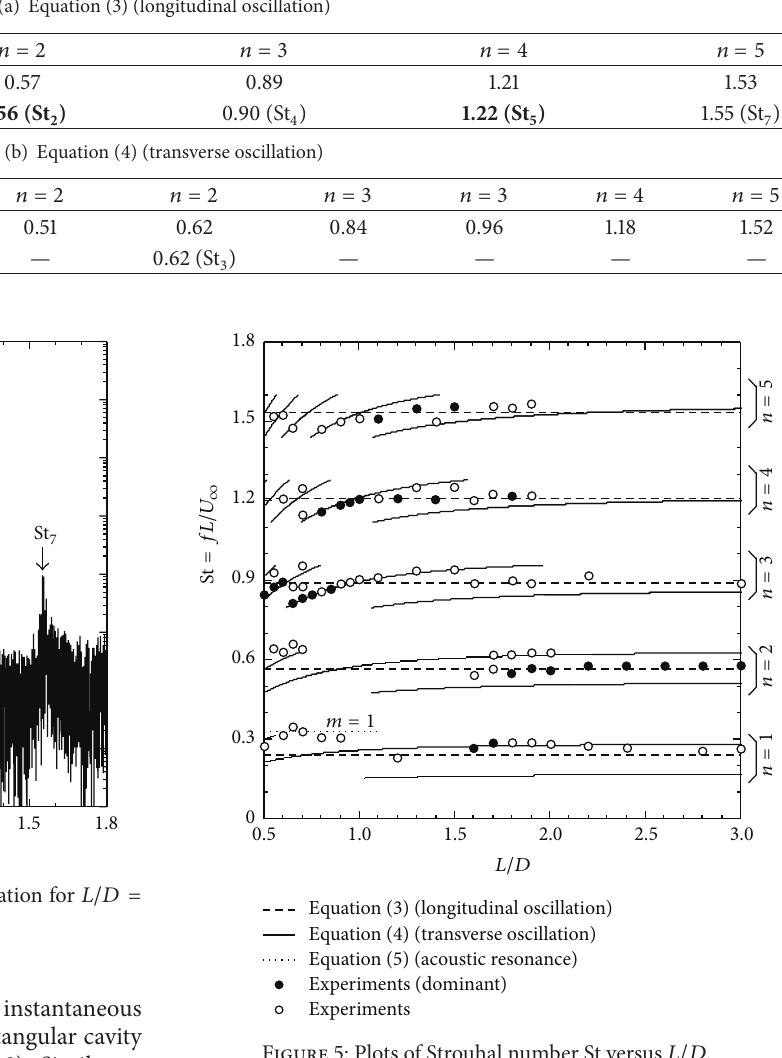
Figure 6. In the calculation of Δ𝑝 rms , the spectral